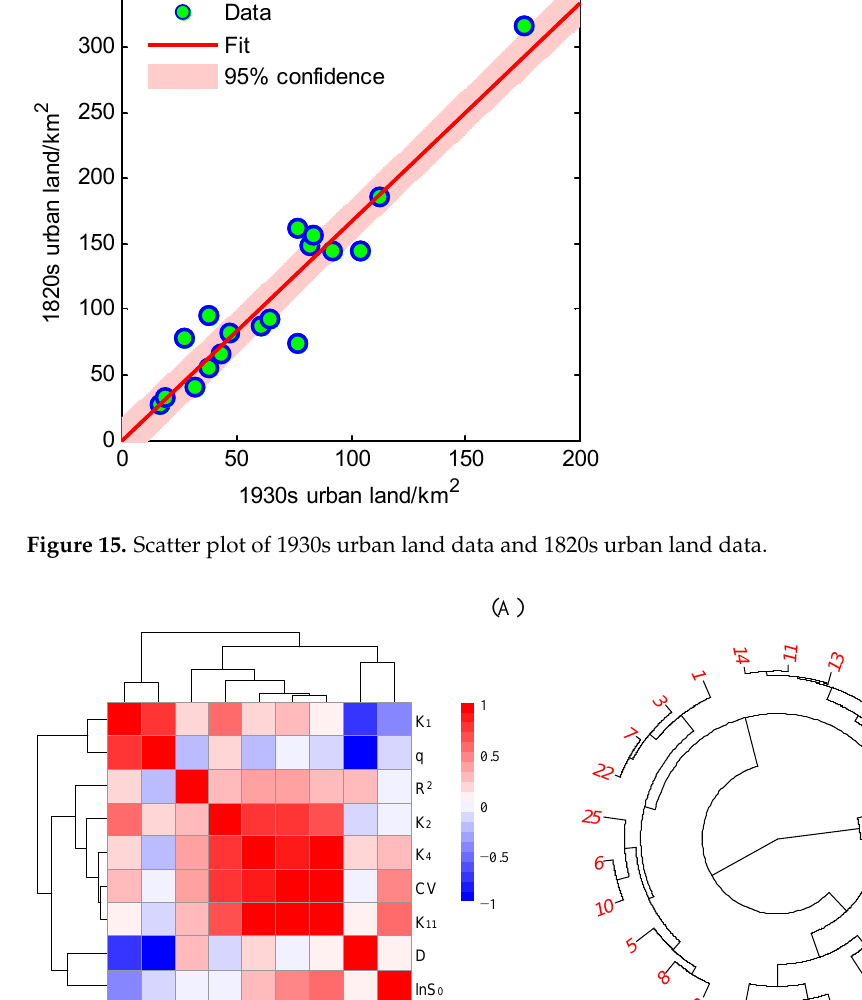
Figure 15. Scatter plot of 1930s urban land data and 1820s urban land data.